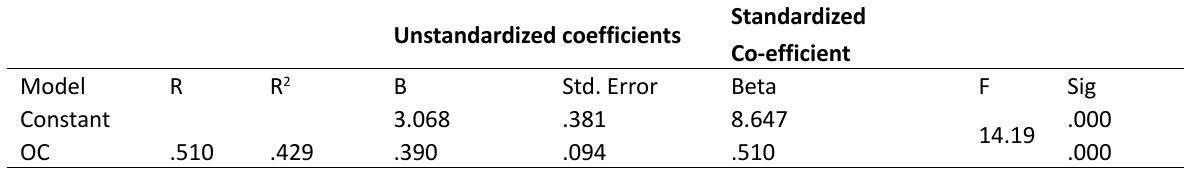
Table 5. Regression model regarding effect of Organizational Climate upon Job Performance